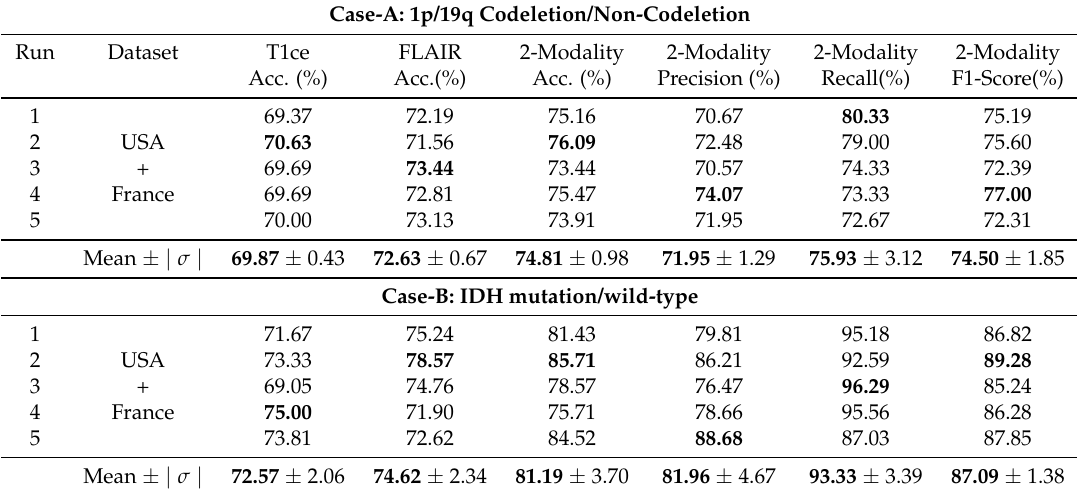
Figure 11. Training and validation performance as a function of epochs from the refined training (green) and validation (red) curves. Early stopping strategy was applied, where blue dot points to the epoch whose parameters were used for test set. Left: Case-A: the validation curve converged at epoch = 95 and then stabilizes. Right: Case-B: the validation curve converged smoothly at epoch = 74 and then stabilizes. Table 4. Average test results of 2 datasets with domain mapping for Case-A and Case-B for 5 runs. The highest value obtained in each run is displayed in bold